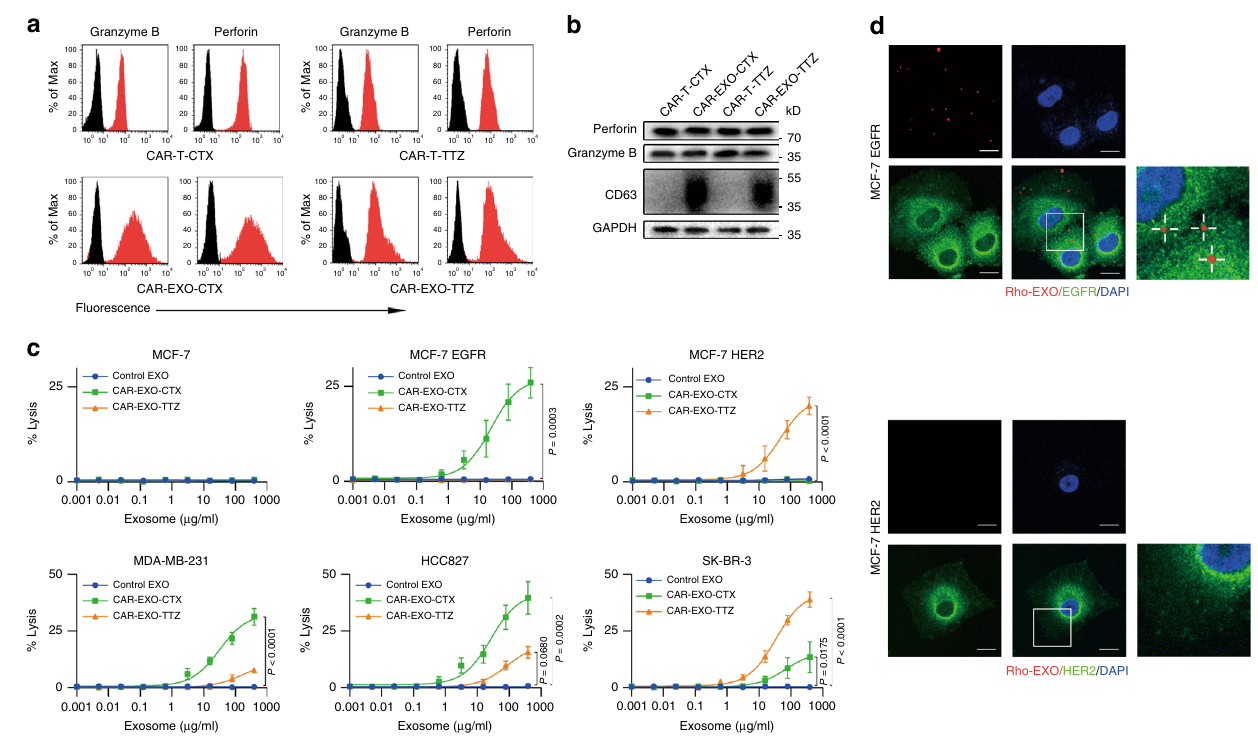
Fig. 4 Cytolytic activity of CAR exosomes in vitro. a Flow cytometry analyses of CAR exosomes linked to latex beads (4-mm diameter) or CAR-T cells stained with the indicated primary Abs. The histograms shown in black correspond to the isotype controls of the respective Abs, whereas the red histograms indicate positive fl uorescence. b Immunoblots for perforin and granzyme B expression in CAR exosomes and CAR-T cells. c Killing activity of CAR exosomes in response to tumour cells. The cytotoxic activity of CAR exosomes and control T cells against cancer cell lines was assessed by the 51 Cr- release assay at the indicated concentration. d Confocal microscopy analysis of MCF-7 EGFR cells (up) and MCF-7 HER2 cells (down) after incubation with NHS-Rhodamine (Rho)-labelled CAR-EXO-CTX for 2 h. The experiments were repeated independently three times with similar results. Scale bars = 10 μ m. Results shown represent three ( a , b , d ) independent experiments. Data are the means ± s.d. of three ( c ) independent biological replicates. P values were from a nonparametric t test ( c ). Source data ( b , c ) are provided as a Source Data fi the recombinant PD-L1 and anti-PD-L1 antibodies nearly abol-